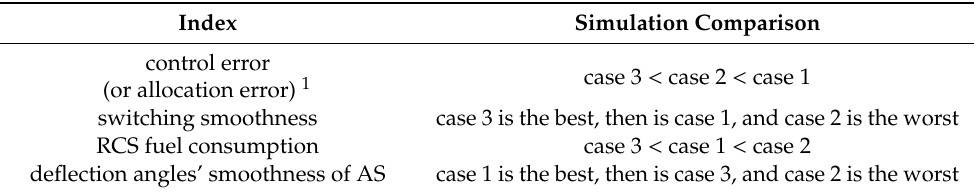
Table 1. Comparison of the three allocation schemes.